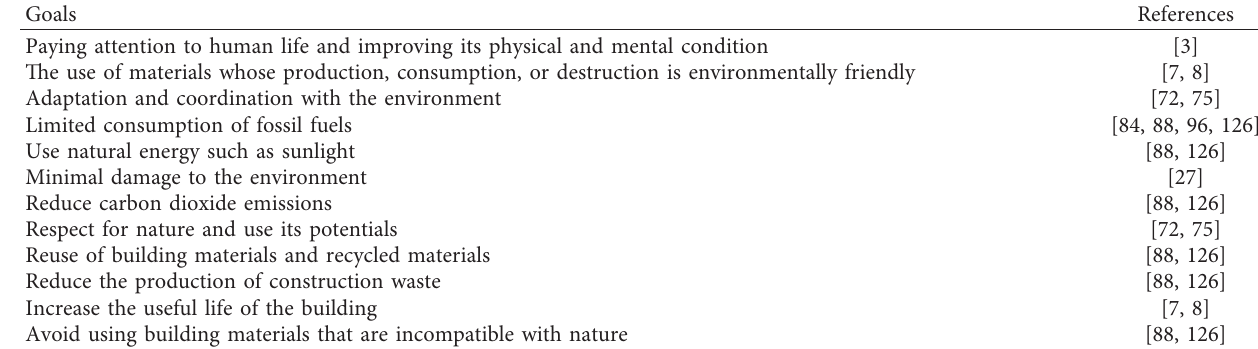
Table 1: The goals of sustainable